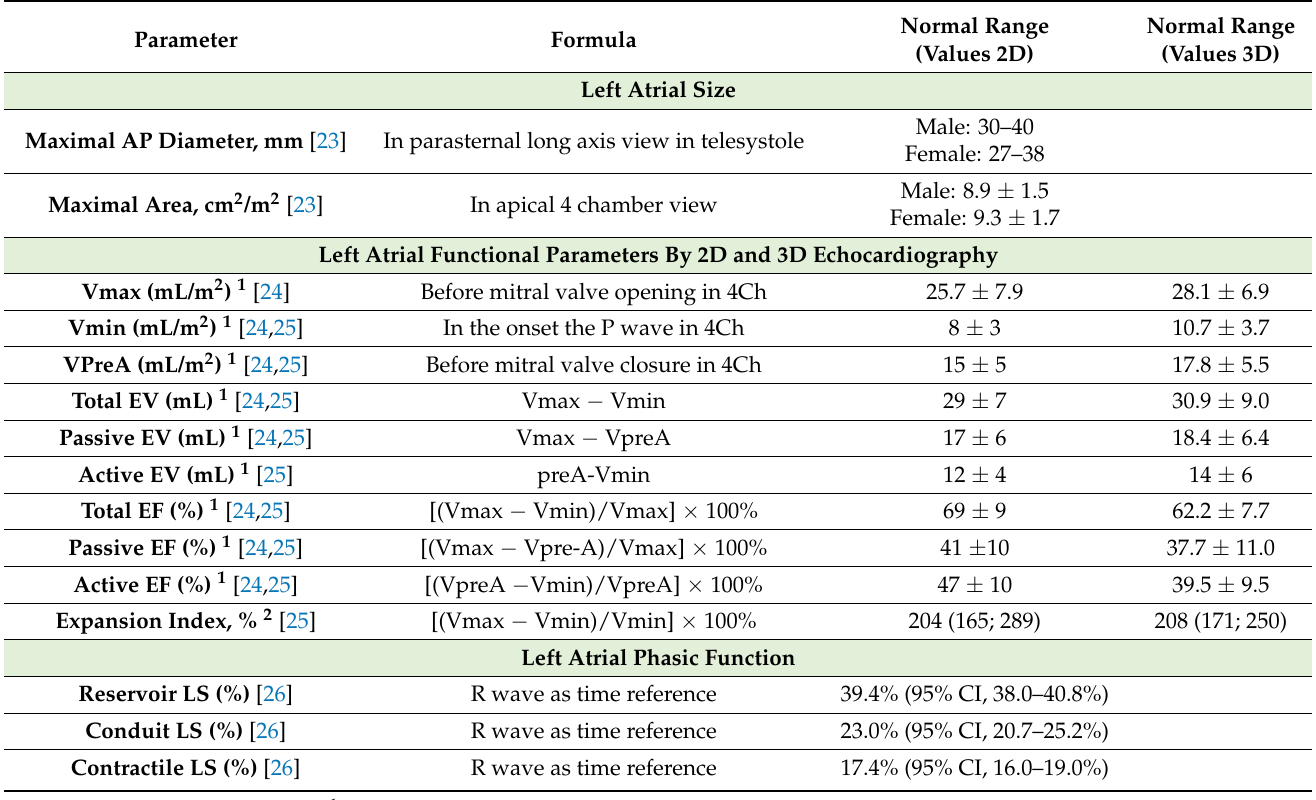
Table 1. Reference ranges of LA dimension and function by 2- and 3-dimensional